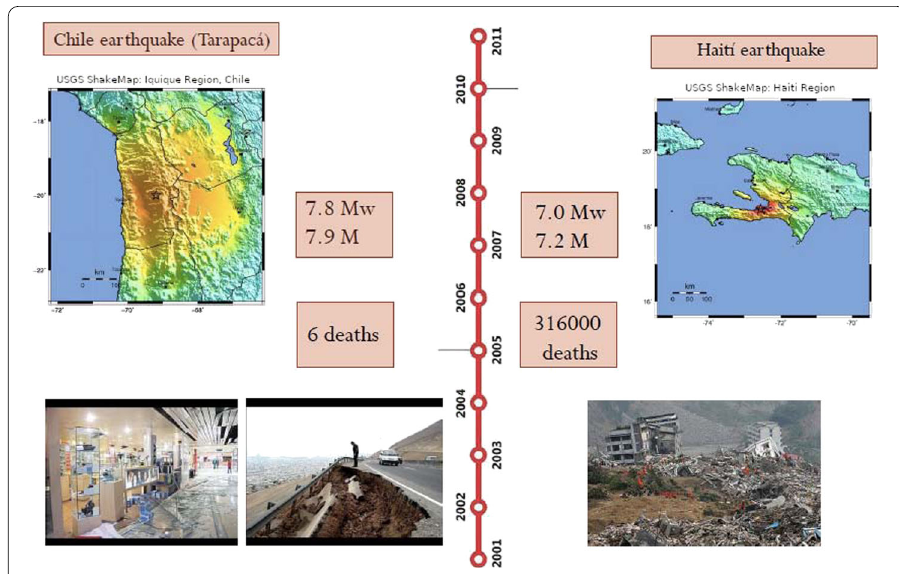
Figure 1 Two earthquakes that released almost the same amount of energy. Two earthquakes that released almost the same amount of energy, but with very different effects on the population. Tarapacá earthquake recorded VII in Mercalli whilst Haití earthquake recorded